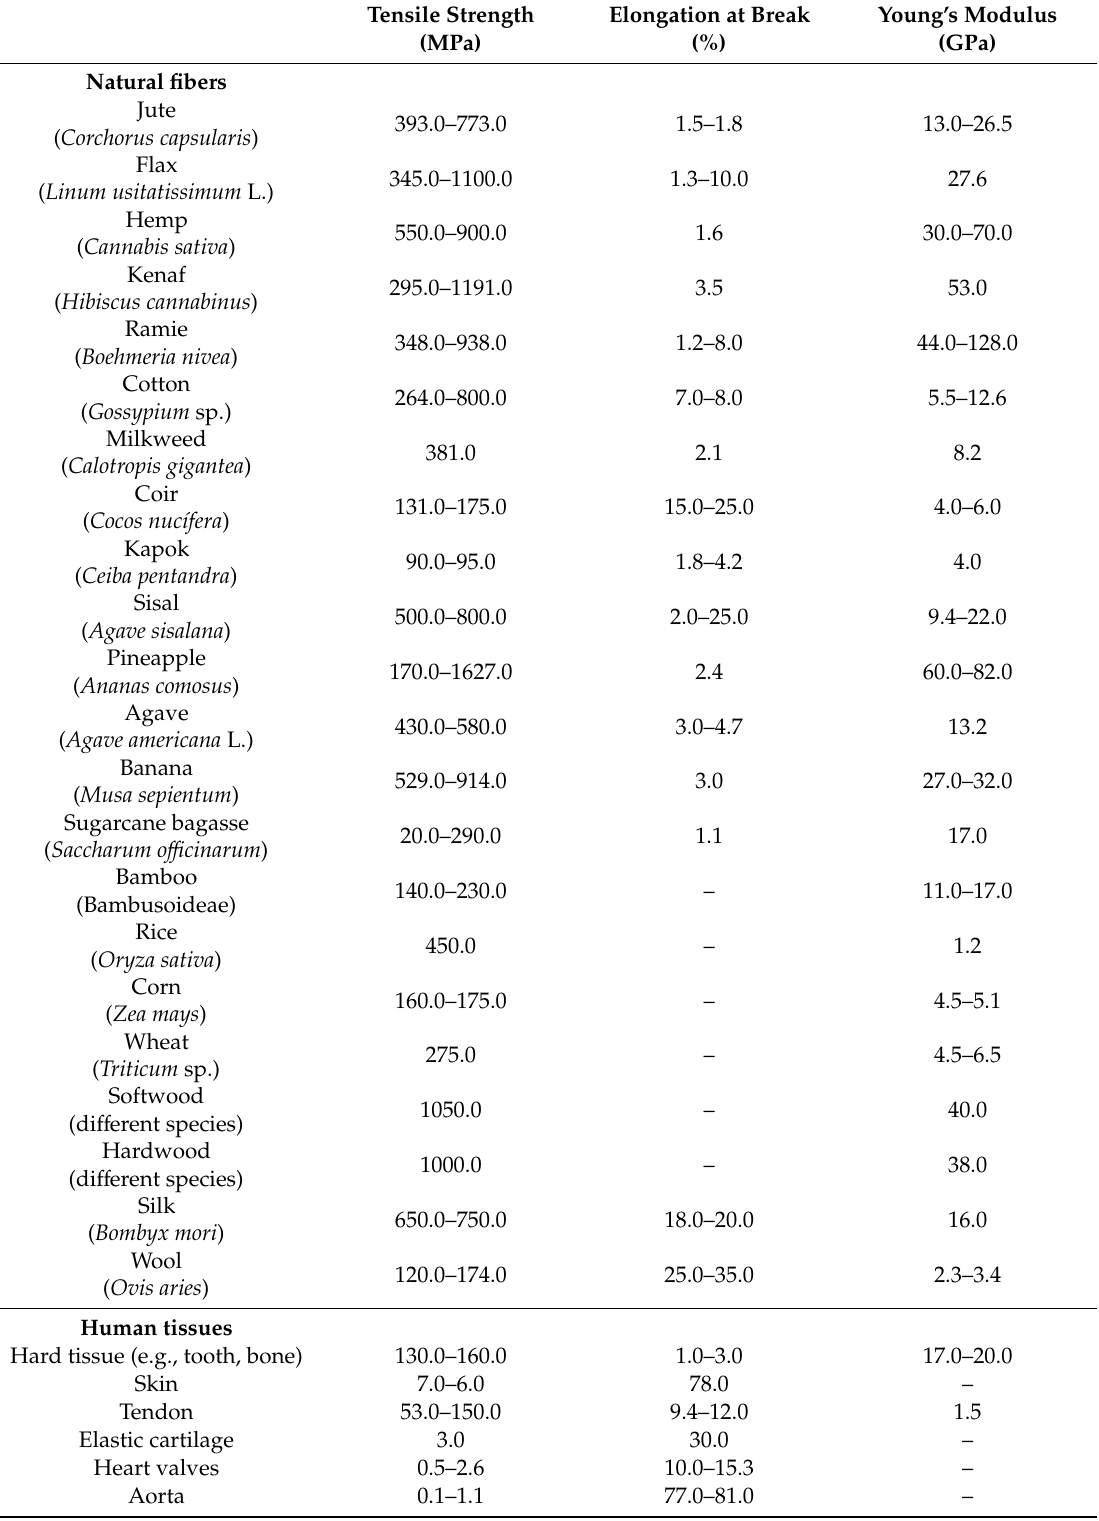
Table 1. Mechanical properties of natural fibers and human tissues comparatively (adapted from